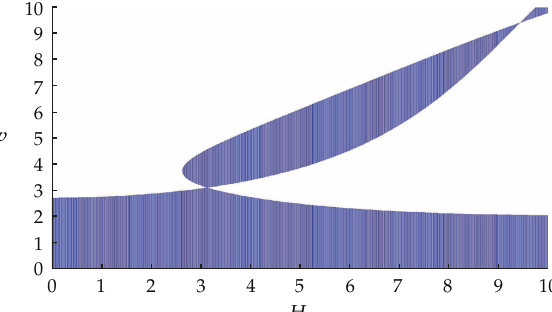
Figure 2: v- H plane of the new developed method.